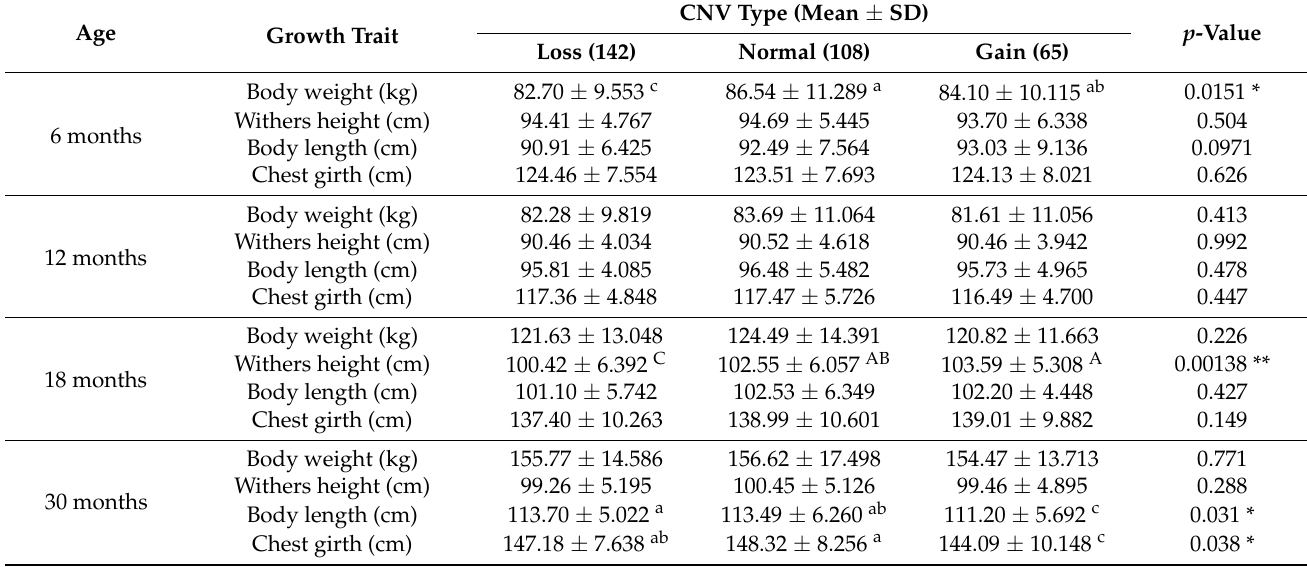
Table 2. Correlations between MICALL2 CNVs and Ashidan yak growth traits.